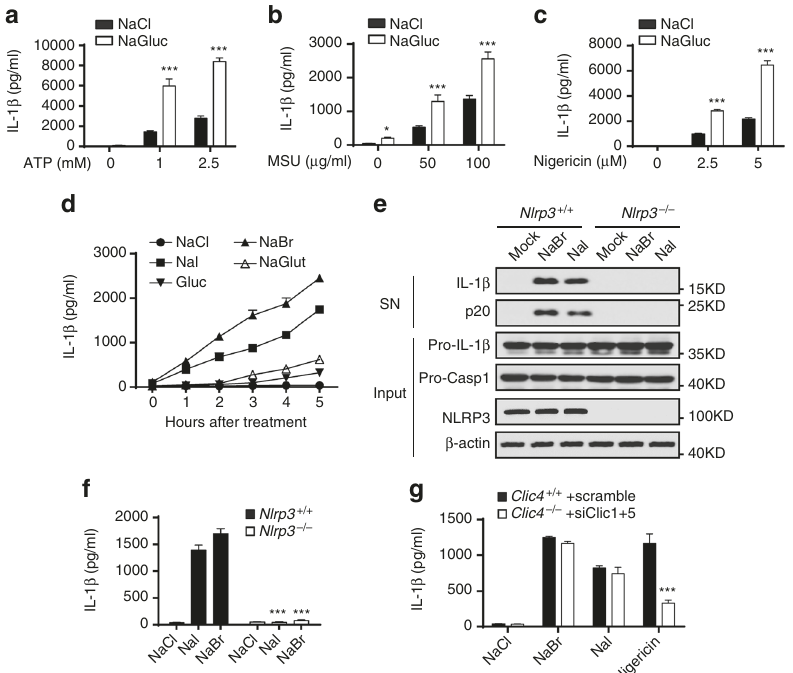
Fig. 5 Chloride ef fl ux is essential for NLRP3 in fl ammasome activation. a – c ELISA of IL-1 β in LPS-primed BMDMs which were transferred to a basic NaCl saline (130 mM NaCl, 5 mM KCl, 1 mM MgCl 2 , 1 mM CaCl 2 , 20 mM HEPES (pH 7.4), 1 mg/ml BSA, 10 mM glucose) or chloride-free NaGluc saline (130 mM NaGluc, 5 mM KGluc, 1 mM MgGluc 2 , 1 mM CaGluc 2 , 20 mM HEPES (pH 7.4), 1 mg/ml BSA, 10 mM glucose) and left stimulated with ATP a , MSU b , or nigericin c . d ELISA of IL-1 β in LPS-primed BMDMs which were transferred to NaCl saline, NaBr saline (130 mM NaBr, 5 mM KBr, 1 mM MgBr 2 , 1 mM CaBr 2 , 20 mM HEPES (pH 7.4), 1 mg/ml BSA, 10 mM glucose), NaI saline (130 mM NaI, 5 mM KI, 1 mM MgI 2 , 1 mM CaI 2 , 20 mM HEPES (pH 7.4), 1 mg/ml BSA, 10 mM glucose), NaGluc saline or NaGlut (130 mM NaGlut, 5 mM KGlut, 1 mM MgGlut 2 , 1 mM CaGlut 2 , 20 mM HEPES (pH 7.4), 1 mg/ml BSA, 10 mM glucose) saline for different time points. e , f Immunoblot analysis IL-1 β and cleaved caspase-1 e or ELISA of IL-1 β in supernatants f of LPS-primed Nlrp3 + / + or Nlrp3 – / – BMDMs which transferred to NaCl, NaBr or NaI saline for 3 h. g ELISA of IL-1 β in supernatants of LPS-primed Clic4 – / – BMDMs transfected siRNA against Clic1 and Clic5 and left stimulated with nigericin for 30 min or transferred to NaCl, NaBr or NaI saline for 3 h. Data are from three independent experiments with biological duplicates in each ( a – d , f , g ; mean ± SEM of n = 6) or are representative of three